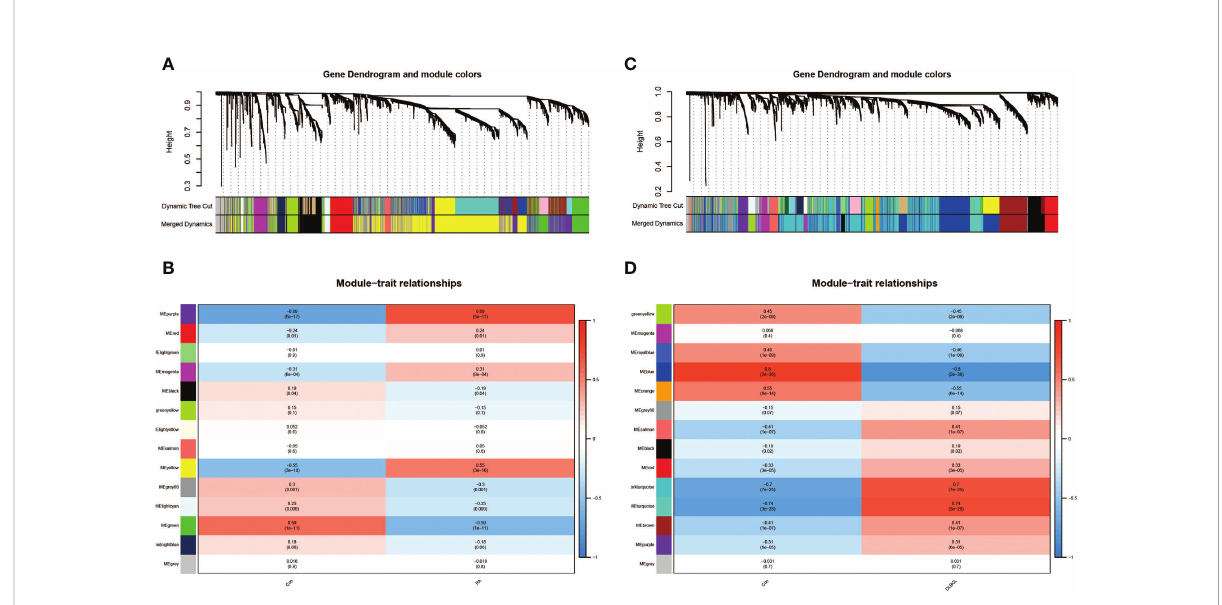
FIGURE 1 Identi fi cation of modules linked to clinical features of RA and DLBCL using WGCNA. (A) Cluster dendrogram of co-expressed genes in RA; (B) Heatmap of module – trait relationships in RA; (C) Cluster dendrogram of co-expressed genes in DLBCL; (D) Heatmap of module – trait relationships in DLBCL. RA, rheumatoid arthritis; DLBCL, diffuse large B-cell lymphoma; WGCNA, weighted gene co-expression network